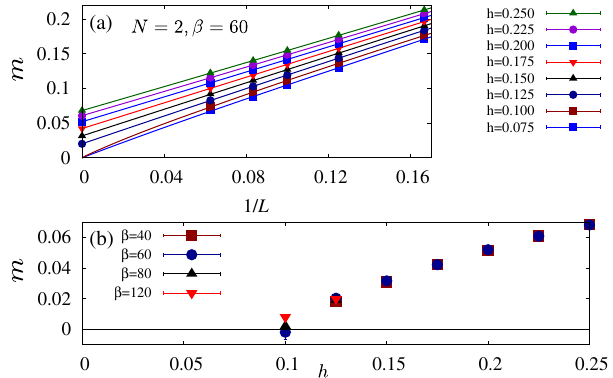
FIG. 11. (a) Magnetization as a function of system size [see Eq. (43)]. In the ordered phase, we have used a second-order polynomial form in 1 =L to extrapolate to the thermodynamic limit. At h ¼ 0 . 1 and h ¼ 0 . 075 , we have set β ¼ 120 and fitted the data to the form f ð x Þ ¼ aL − b . (b) Estimated value of the magnetization in the thermodynamic